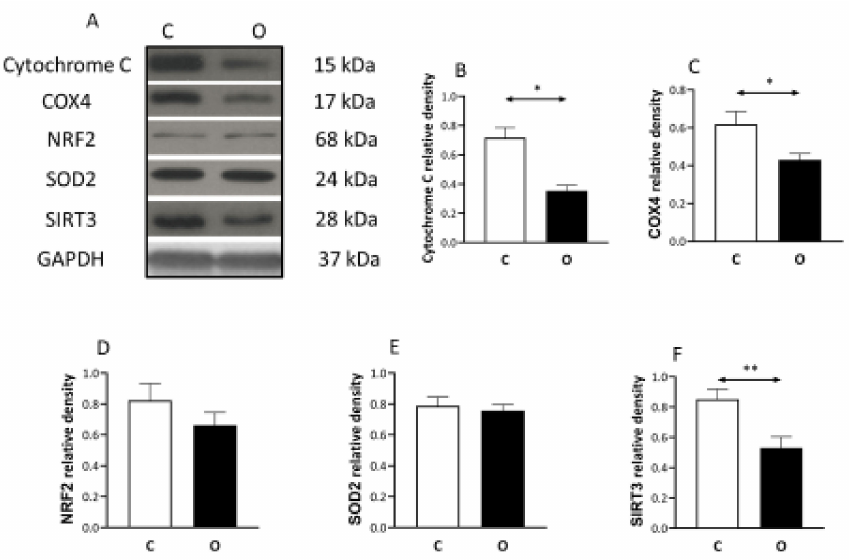
Figure 5. The levels of mitochondrial proteins in hypertrophied muscle. The levels of mitochondrial related proteins suggest that the increase in muscle mass was not associated with the increase in mitochondrial proteins with the same degree during overload-induced hypertrophy. ( A ) panel shows the selected immunoplot signals, and ( B – F ) panels show the densitometric results of nine samples in each group. C: control group, O: Overloaded group, n = 9, * p <0.05, ** p < 0.01, Results are expressed as mean ±